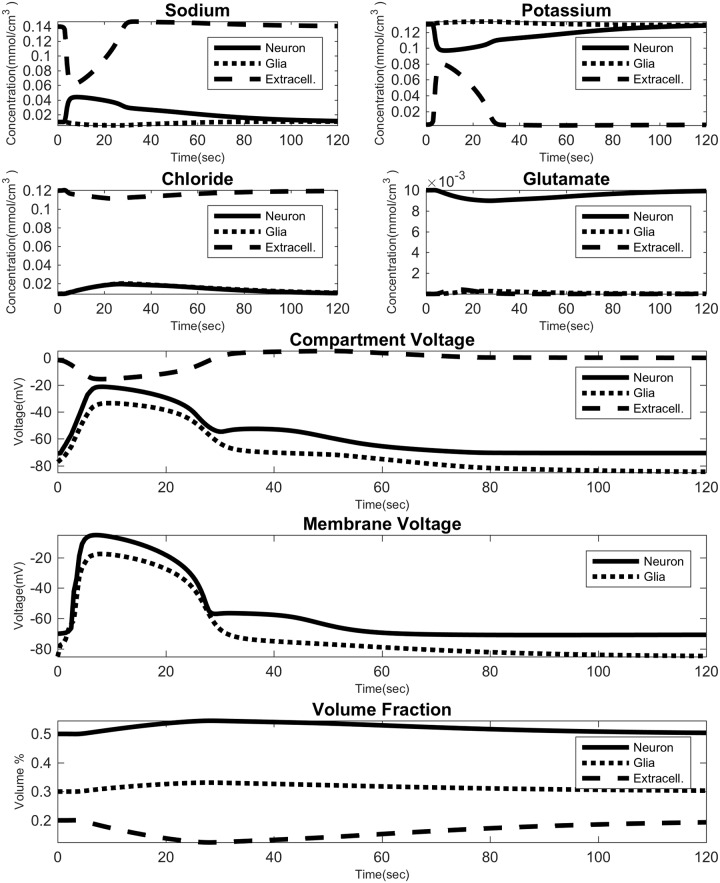
Example 1D simulation.The time course of all variables with PNMDA = 1 × 10−5cm/s and PNaP = 2 × 10−5cm/s. For a 0.5cm domain Δx = 0.0156cm with Δt = 0.01s. The time course is from the third grid point from the left end of the domain.